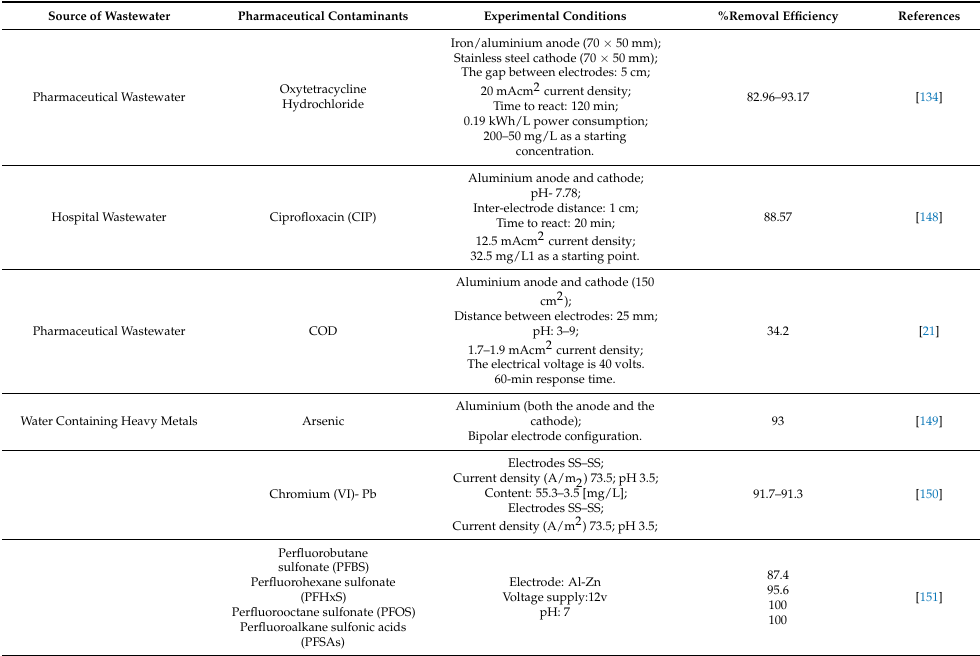
Table 4. Few past studies carried out for pharmaceutical removal by